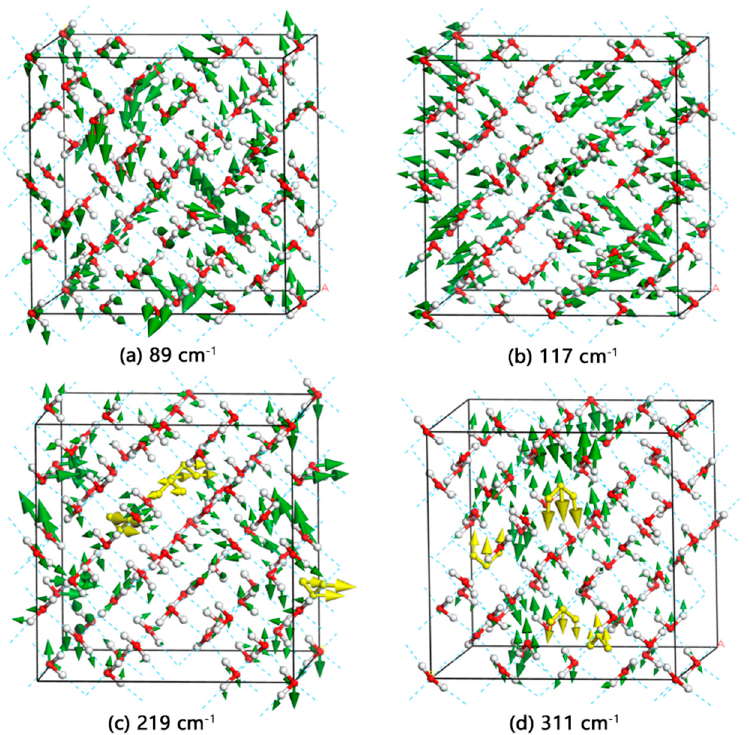
Figure 3. Four examples of normal modes in the translational band of ice Ic. ( a , b ) are two cluster vibration modes. ( c , d ) are the two-bond and four-bond modes. Representative vibrating molecules are shown in gold. Arrows represent the vibrational direction of the atoms and are proportional in size to the vibration amplitude. Dotted lines indicate H-bonds.